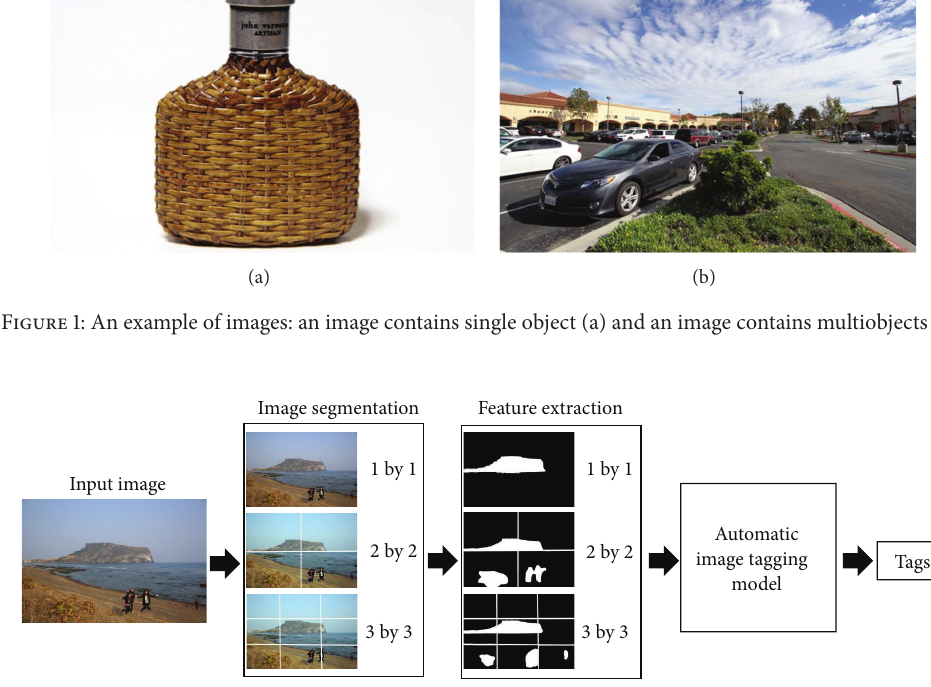
Figure 2: Overview of our grid based image segmentation, feature extraction, and automatic image tagging